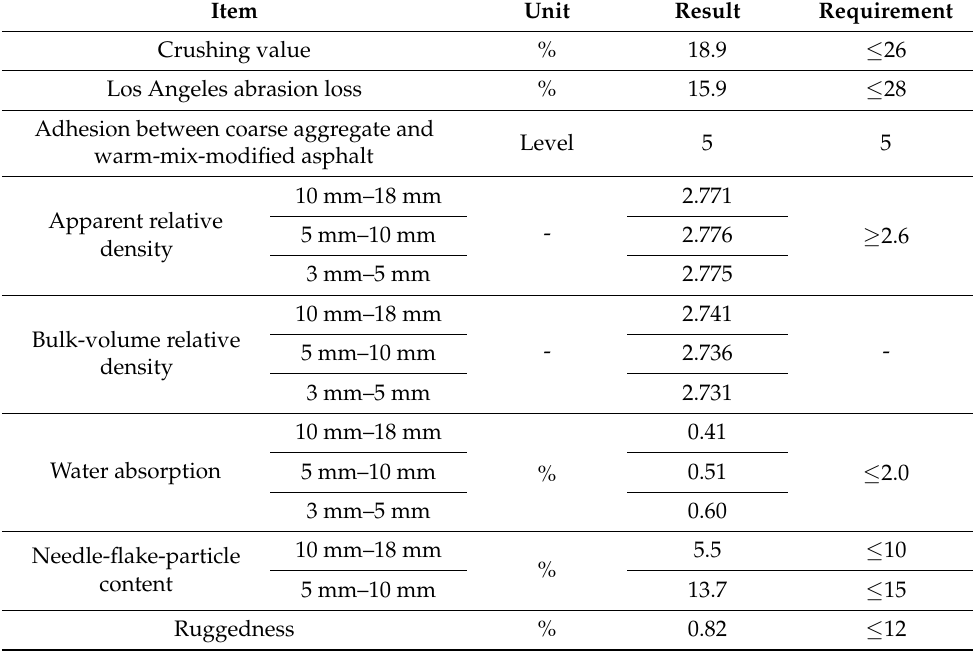
Table 5. Coarse-aggregate test